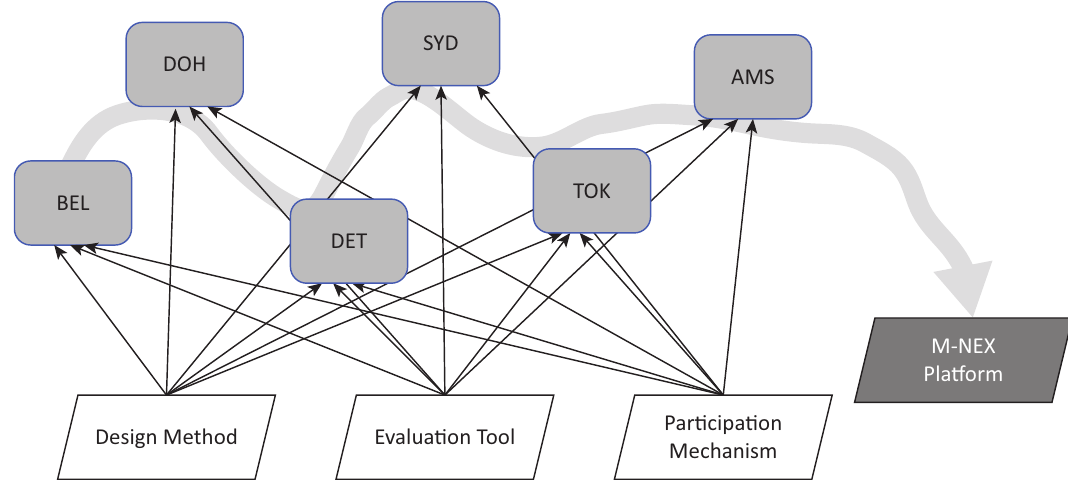
Figure 3. Scheme for the implementation of the moveable